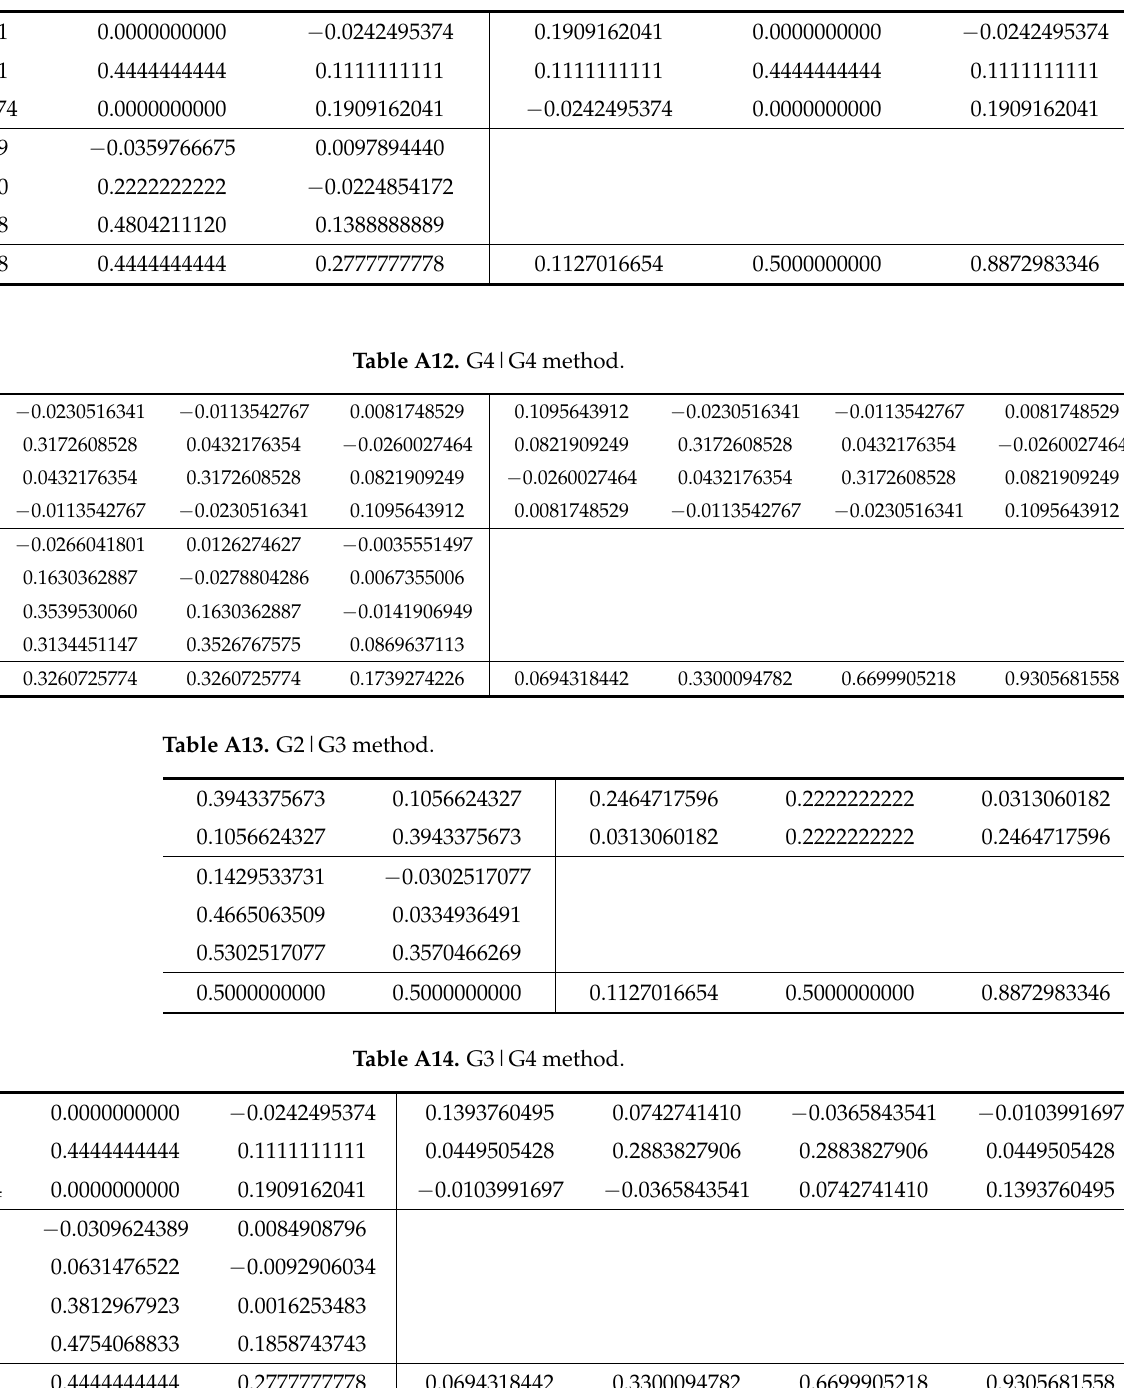
Table A11. G3|G3 method.